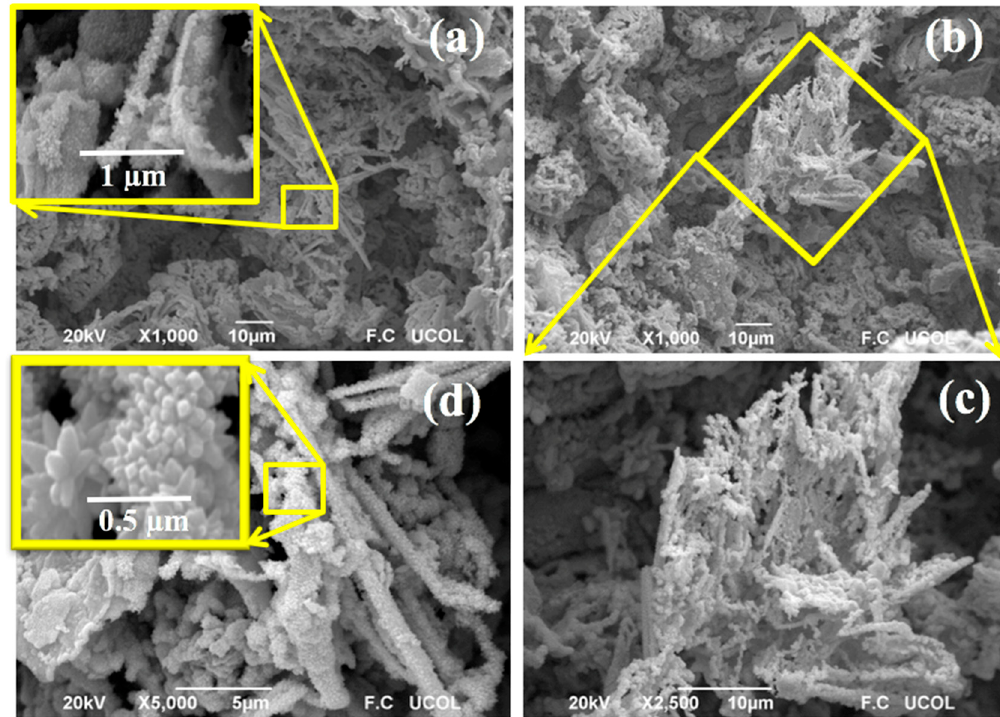
Figure 3. SEM photomicrographs showing the surface’s microstructure of the manganese antimonate calcined at 800 °C at magnifications: ( a ) 1000×, ( b ) 1000×, ( c ) 2500× and ( d ) 5000×.